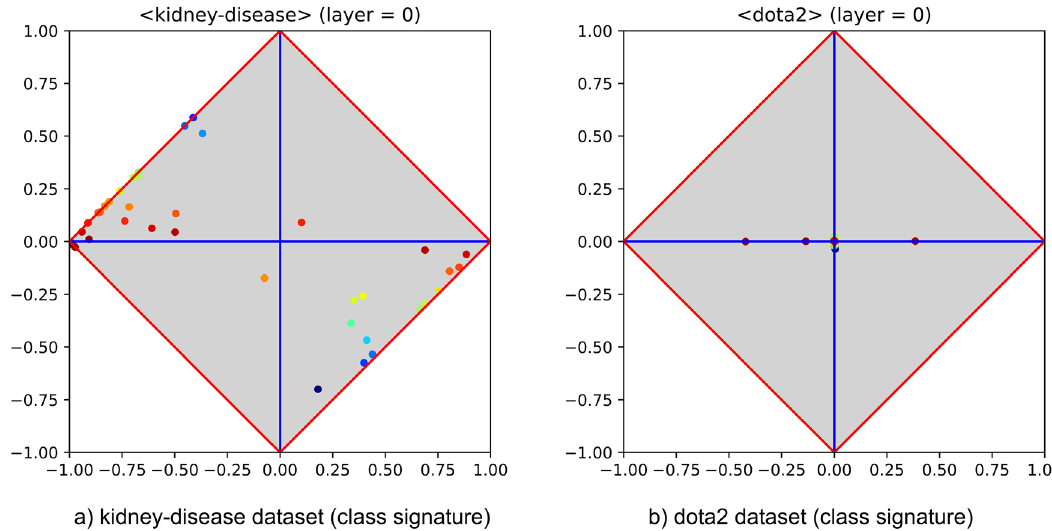
Figure 2. Two typical class signatures, for easy and difficult classification problems. In particular, the toy problem kidney-disease is reported at the left-hand side, whereas the (expected to be) difficult problem dota2 is reported at the right-hand side. Both datasets have been downloaded from